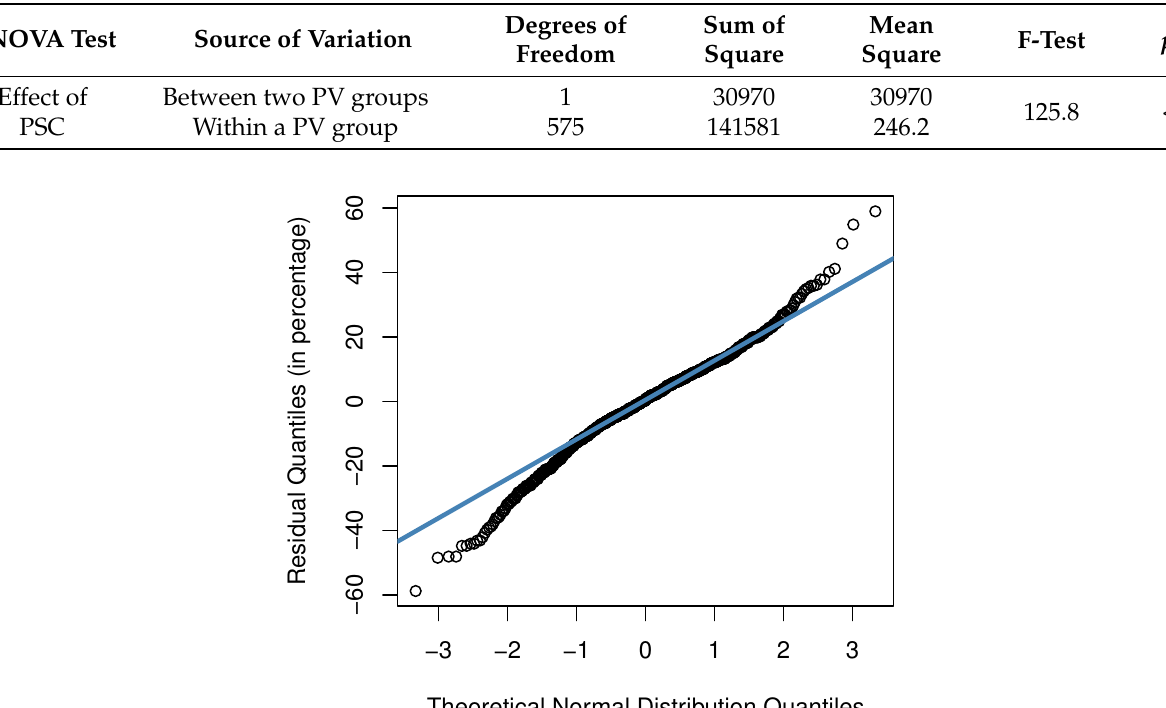
Figure 6. The Q-Q plot of average model. The points located approximately along the reference line (blue line) indicate that the residuals’ normality assumption is